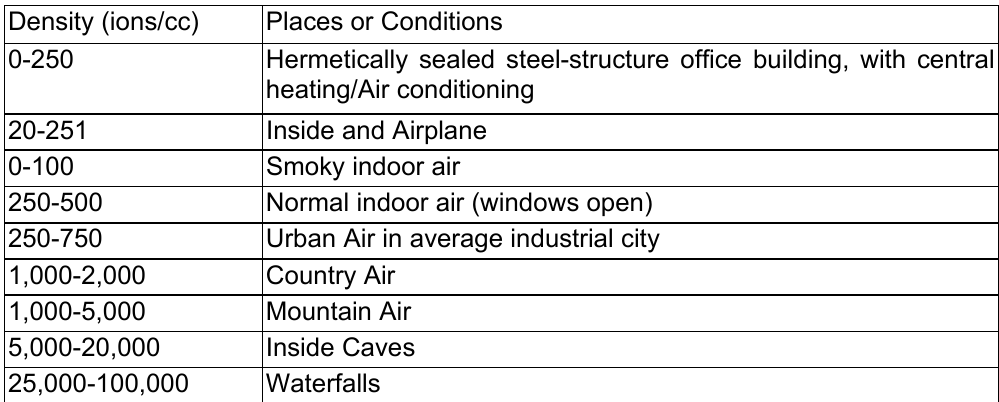
Table 1.2: Negative Ion Densities in Places or